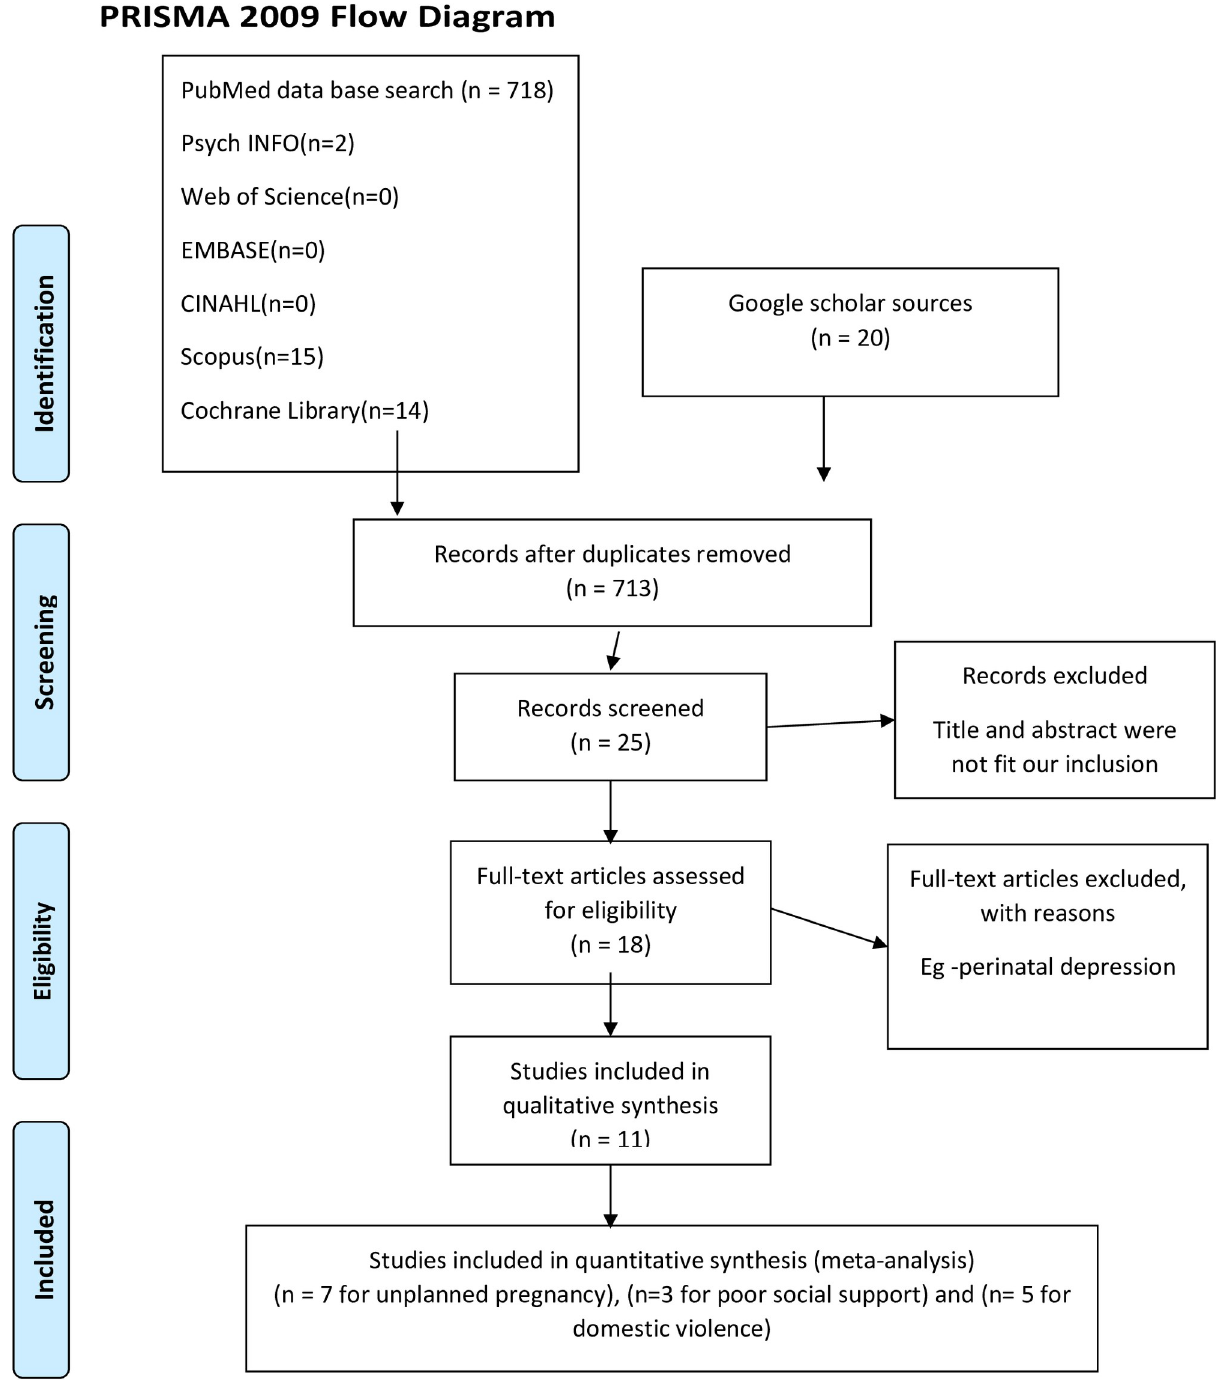
Fig 1. Flow chart showing how was the research articles were searched, 2020.